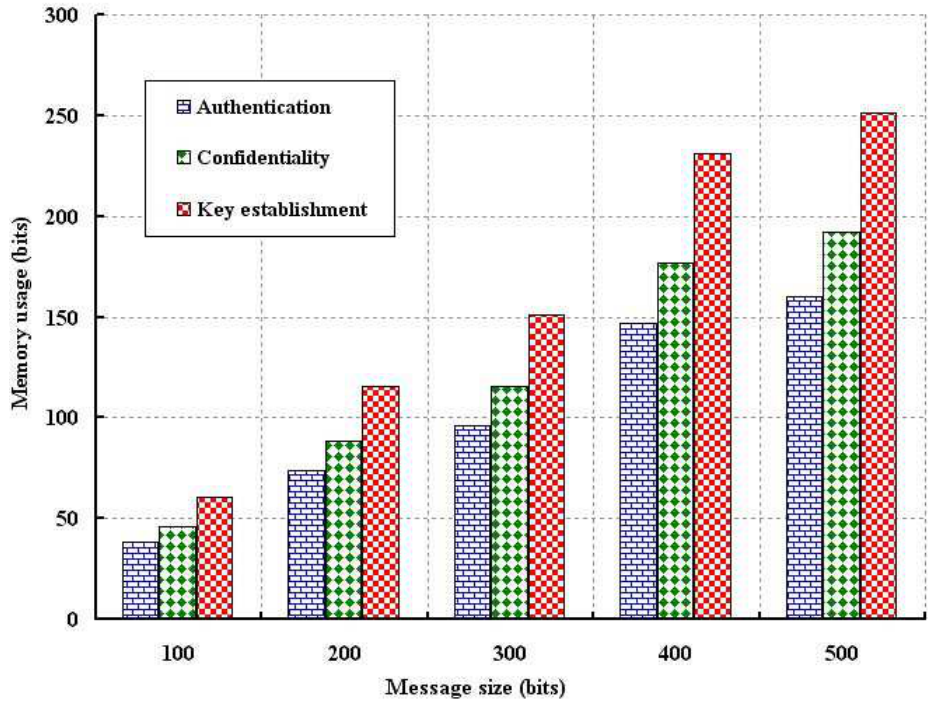
Figure 12. Evaluation of memory usage with different packet size in